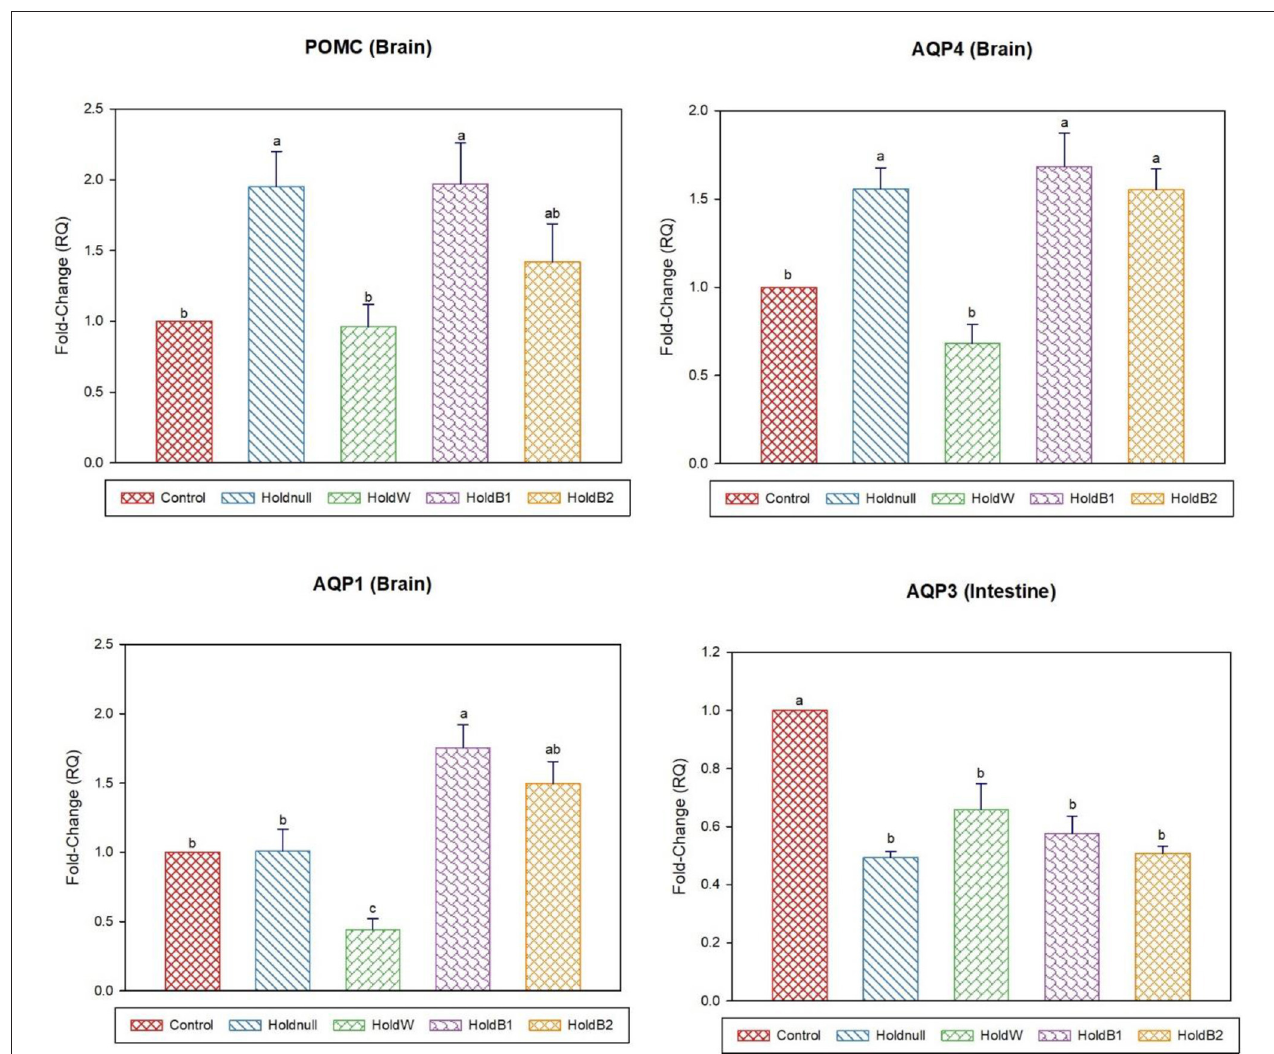
FIGURE 1 | Effect of betaine on the relative expression (fold-change or RQ) of POMC, AQP4, AQP1 in the brain, and AQP3 in the intestine of day-2 old chicks. Control, placed on feed immediately; Holdnull, holding for 48 h + no access to feed or water; HoldW, holding for 48h + water only; HoldB1, holding for 48h + water supplemented with betaine (1ml per L); HoldB2, holding for 48h + water supplemented with betaine (2ml per L). Bars with different letters are significantly different ( p < 0.05). Mean ± standard error of the mean, n = 6. AQP, aquaporin; POMC,